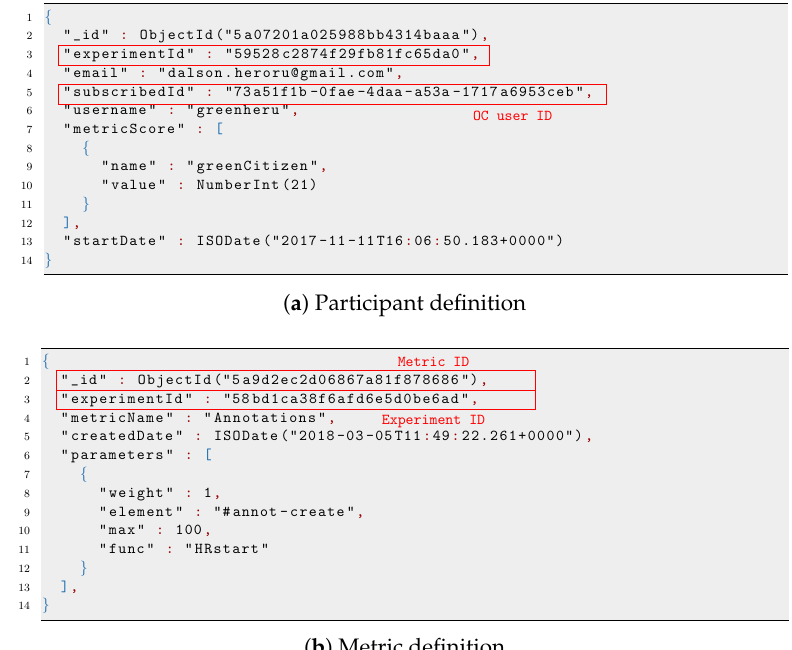
Figure 4. Examples of participant and metrics defined for one